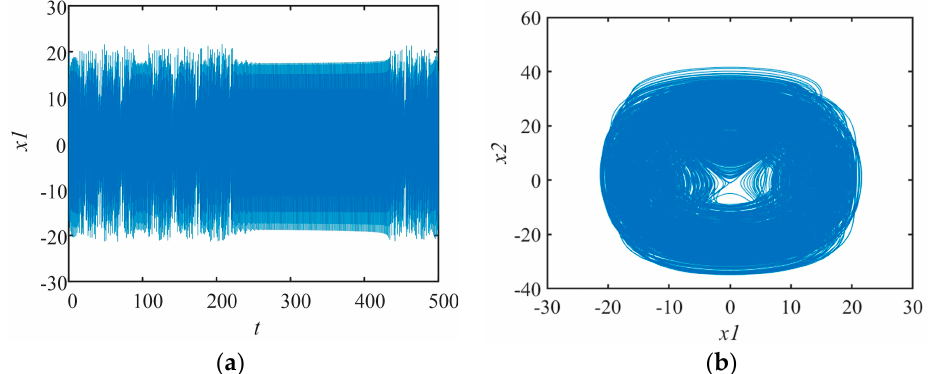
Figure 10. Timing diagram of the chaotic system with t = (0, 500), ( a ) time series diagram, ( b ) phase diagram of chaotic attractor.